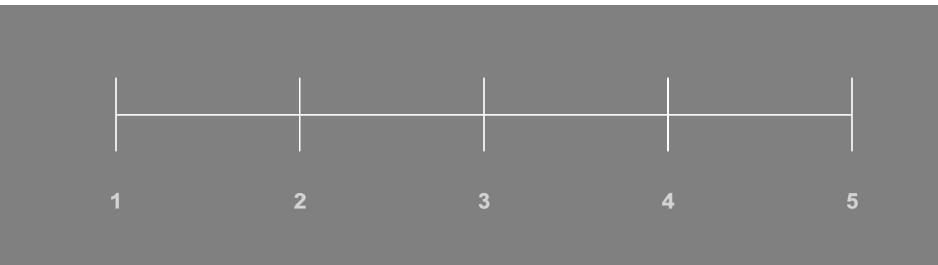
Figure 4. Continuous Likert-style scale for rating the goodness of fit after each vowel